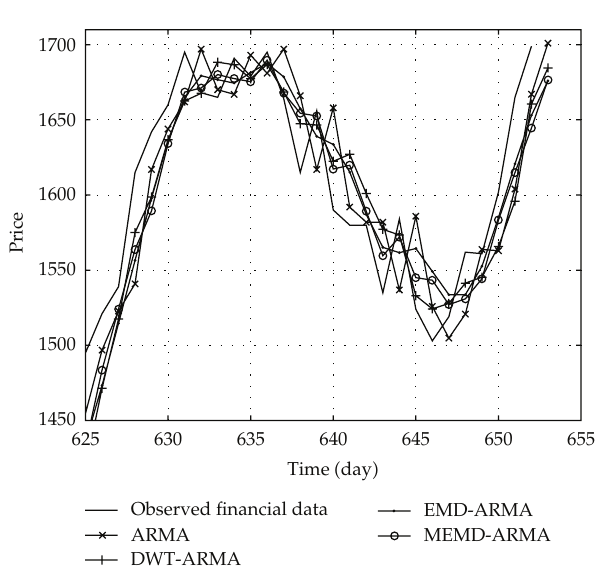
Figure 9: Original time series and predicted data using di ff erent model.